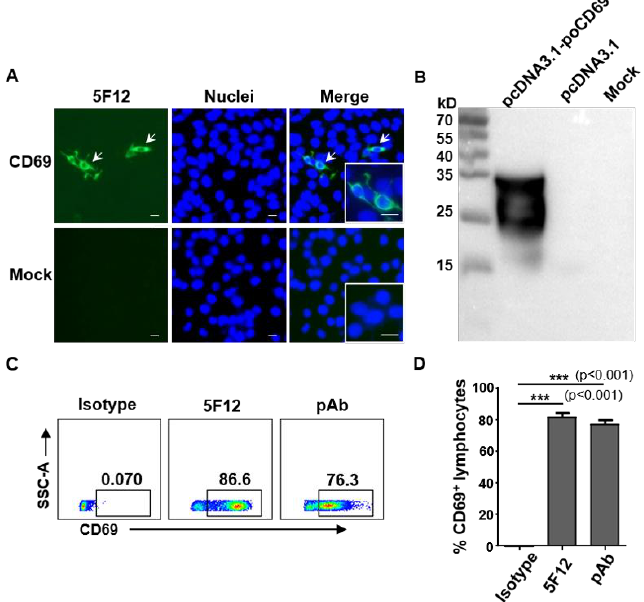
Figure 1. mAb 5F12 specifically recognizes recombinant and natural porcine CD69 protein. ( A ) Recombinant porcine CD69, expressed in pcDNA3.1-poCD69-transfected HEK-293T cells, was detected by mAb 5F12 against porcine CD69. The CD69-positive cells (white arrows) and negative cells were magnified. Scale bars, 40 μm. ( B ) mAb 5F12 specifically recognizes recombinant porcine CD69 in the cell lysates of pcDNA3.1-poCD69-transfected HEK-293T cells but not in pcDNA3.1-transfected or un-transfected HEK-293T cells (Mock) by Western blotting. ( C , D ) The expression of CD69 on pig lymphocytes was detected by mAb 5F12 and polyclonal anti-poCD69 (pAb) antibodies, followed by Alexa Fluor 488-labeled goat anti-mouse-IgG antibody, via flow cytometry after stimulation with PMA (50 ng/mL) and ionomycin (500 ng/mL) for 6 h. These CD69 + lymphocytes were gated on lymphocytes within the PBMCs of pigs. *** p < 0.001.